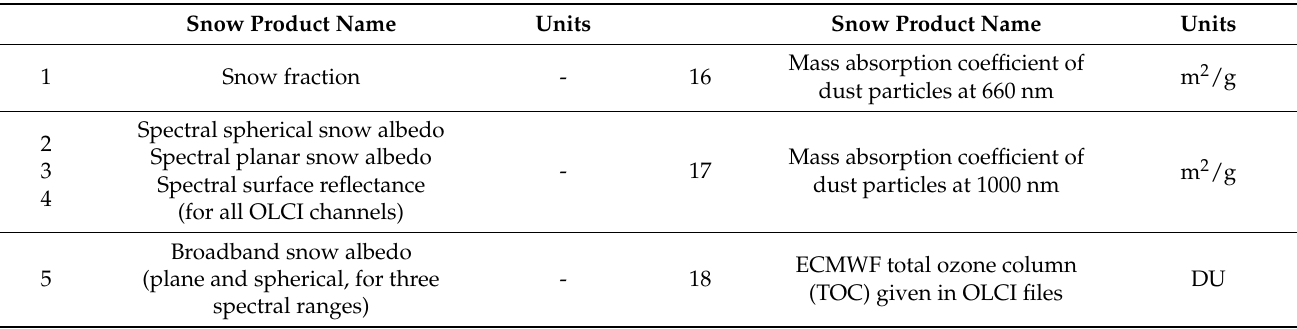
Table A2. SICE-3: Snow and ice